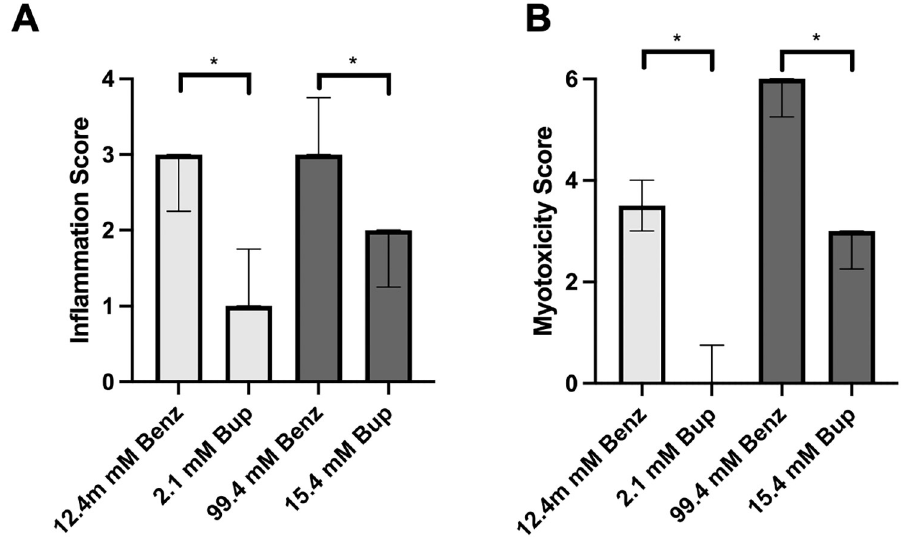
Fig 5. Quantification of tissue reaction. (A) Inflammation and (B) myotoxicity scores of animals injected at the sciatic nerve with benzonatate and bupivacaine. Equieffective concentrations have the same shading. Data are medians with 25 th and 75 th percentiles, n = 4 for all groups. * p < 0.05 for the comparison of equieffective concentrations by Mann-Whitney U